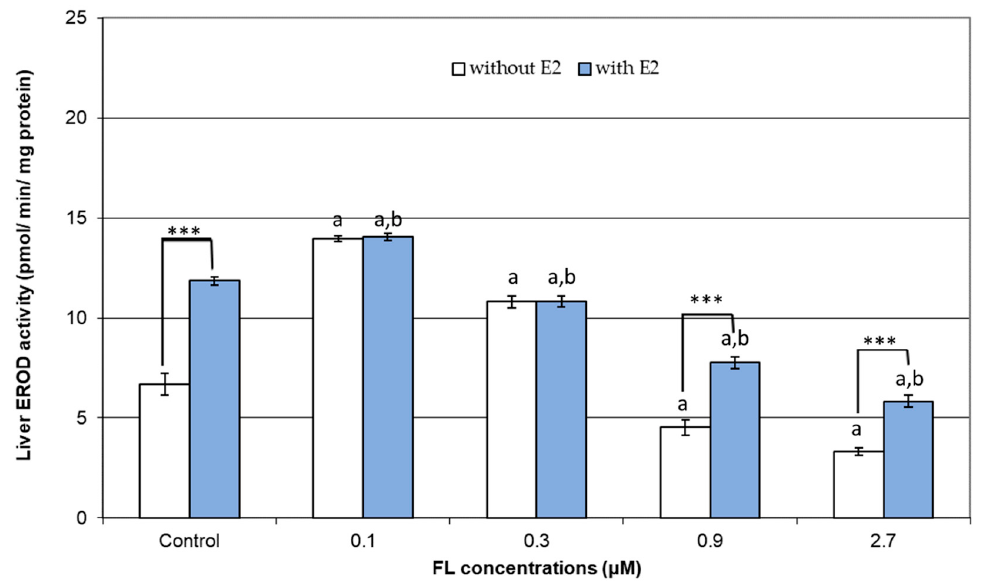
Figure 2. In vitro effects of fluoranthene (FL) on A. anguilla liver EROD activity in the presence and absence of E 2 (5.997 ng/mL). Bars represent mean ± SE ( n = 4). Asterisks (*), significant differences between the presence and absence of E 2 (*** p < 0.001); a, differences from control without E 2 ; b, differences from to control with E2. One-way ANOVA followed by Tukey’s post hoc test.